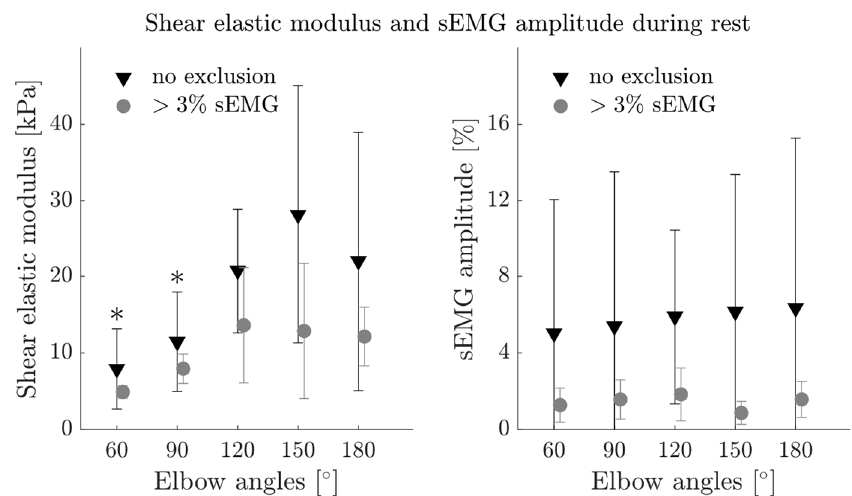
Figure 4. Average shear elastic modulus of the biceps brachii muscle (BB) and sEMG amplitude of the BB during rest (no exclusion, black triangles) and with the exclusion of the sEMG amplitude > 3% (grey circles). Error bars visualize the standard deviation. * Significant different to 150 ◦ elbow angle ( p < 0.05).